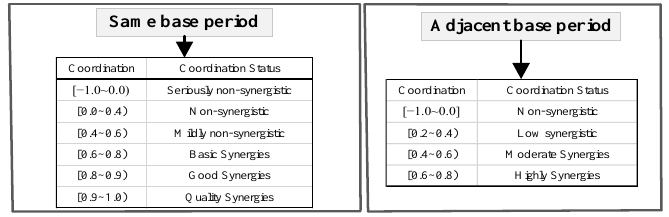
Figure 2. Evaluation criteria for the synergy degree: same and adjacent base periods.